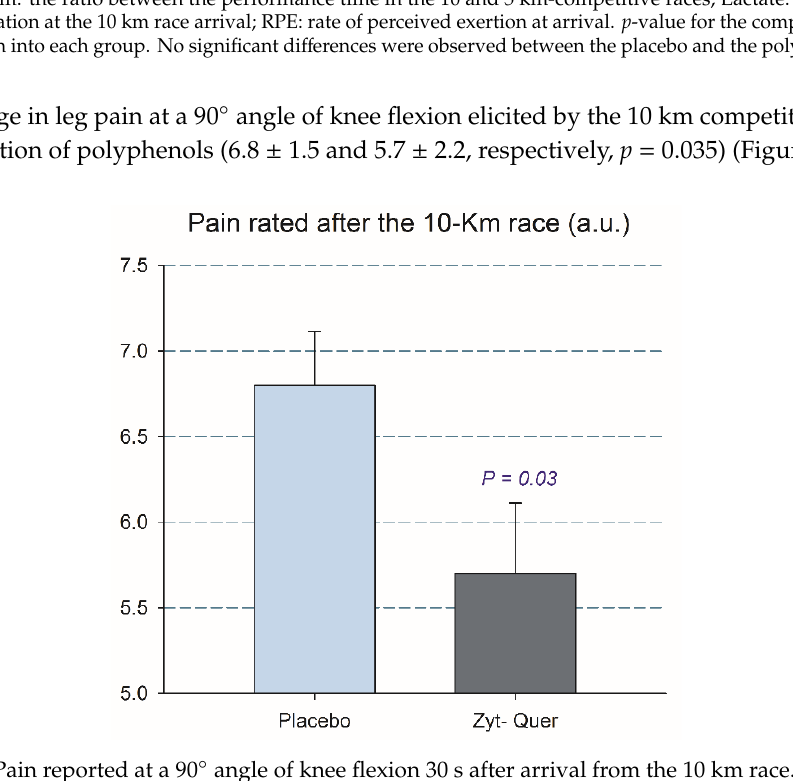
Table 4. Performance and pain after the 10 km race.